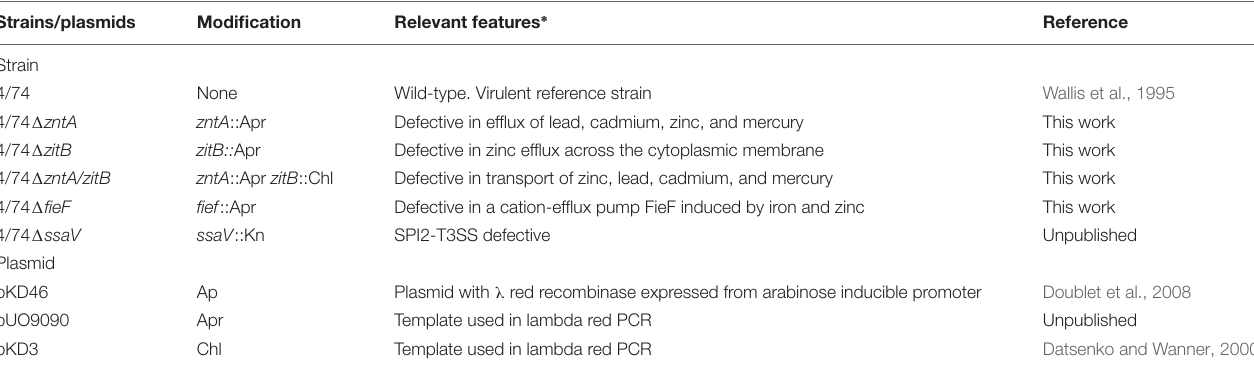
TABLE 1 | Strains and plasmids used in this